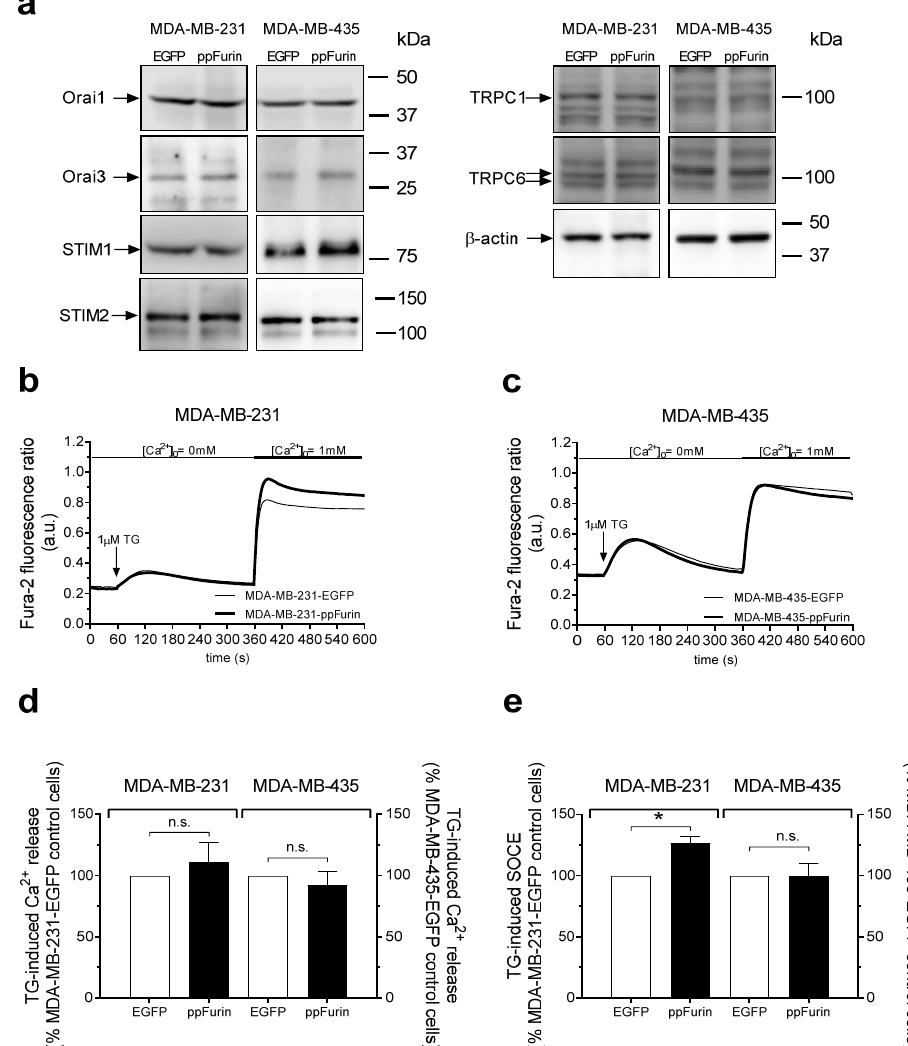
Figure 3. ppFurin enhances store-operated Ca 2+ entry (SOCE) in MDA-MB-231 cells. ( a ) Control MDA-MB-231 and MDA- MB-435 cells or expressing ppFurin were lysed and whole cell lysates were analyzed by Western blotting using anti-Orai1, Orai3, STIM1, STIM2, TRPC1, TRPC6, or β -actin antibody, as indicated. Blot images are from one experiment representative of three which gave similar results. ( b – e ). Changes in [Ca 2+ ] I were detected in fura-2-loaded control MDA-MB-231 and MDA-MB-435 cells or expressing ppFurin. Cells were stimulated with 1 µ M of TG in a Ca 2+ -free medium (100 µ M of EGTA added), and later SOCE was detected by the addition of 1 mM of CaCl 2 to the extracellular medium. ( b , c ) Traces are representative of 40 cells/day/3–5 days. ( d , e ) Histograms indicate TG-induced Ca 2+ release and SOCE as the area under the curve, expressed as mean ± SEM and presented as percentage of their respective control cells. Statistical significance was assessed by Student’s t -test and * represents p < 0.05 as compared to cells transfected with pIRES2-EGFP empty vector.